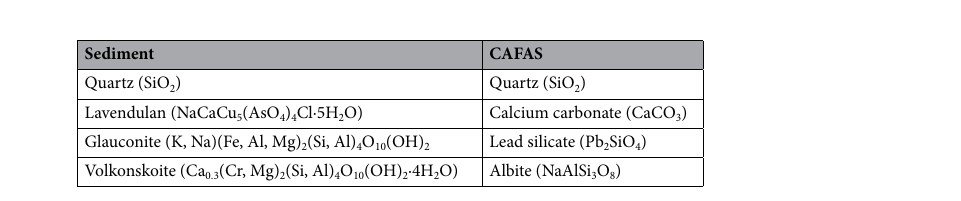
Table 2. Identified crystalline phases of cave